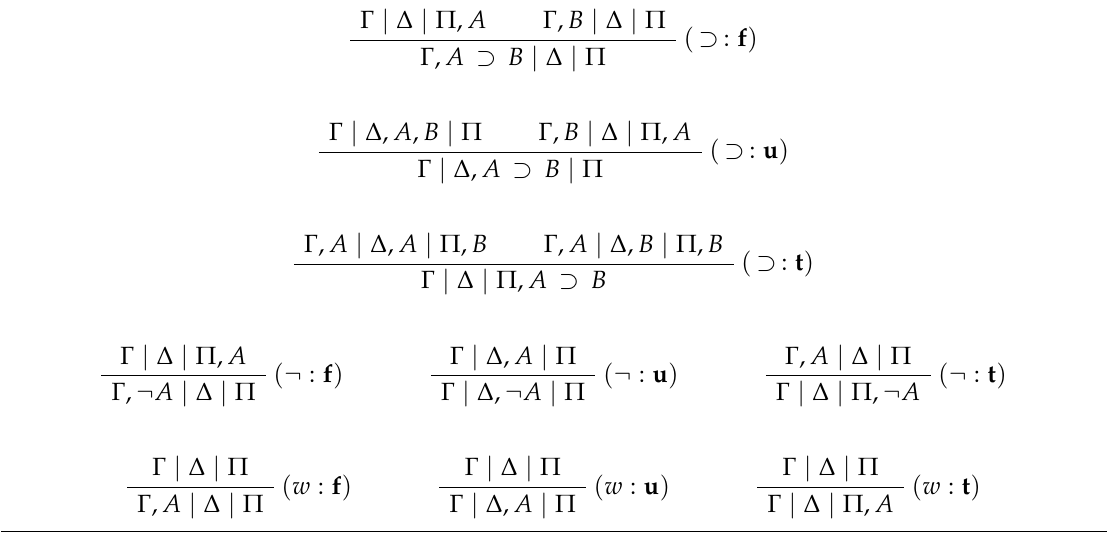
Figure 2. Rules of the sequent calculus S Ł 3